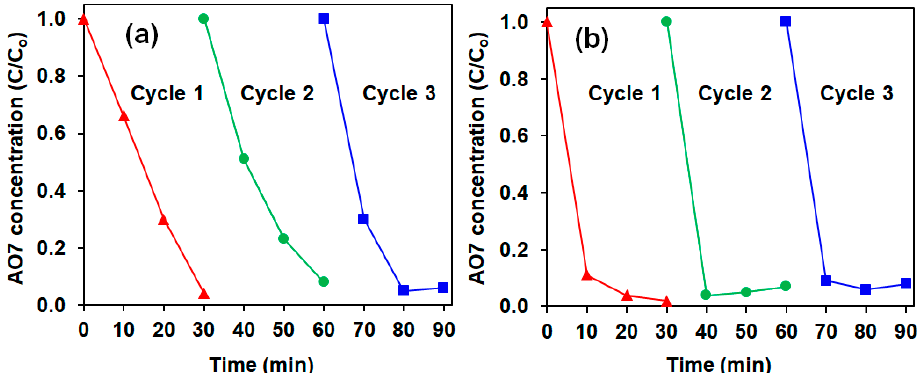
Figure 4. Reusability of Ac-ZVI for ( a ) PMS and ( b ) PDS systems. Conditions: [AO7] = 8.5 mg L − 1 , Table 1. A comparison of Ac-ZVI/Fe 3+ system with other catalysts for AO7 removal. Catalyst Oxidant Performance Ref.